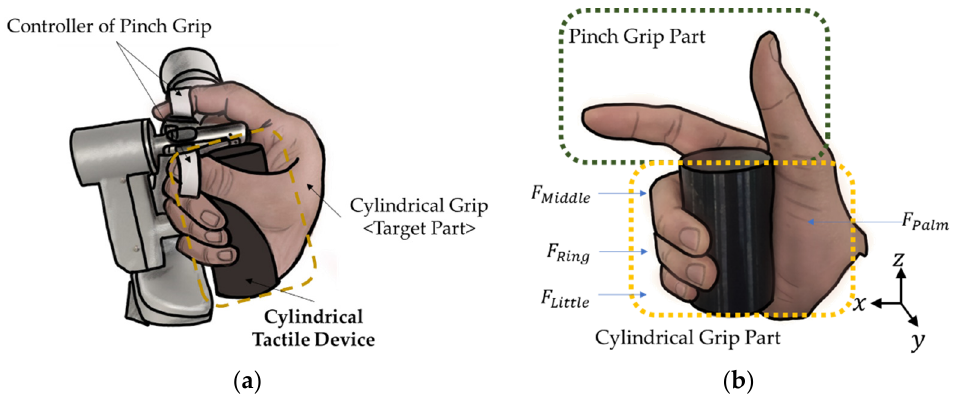
Figure 2. Cylindrical type tactile device combined with the pinch grip; ( a ) MRTGC integrated with the existing console, ( b ) free body diagram of the gripping motion.